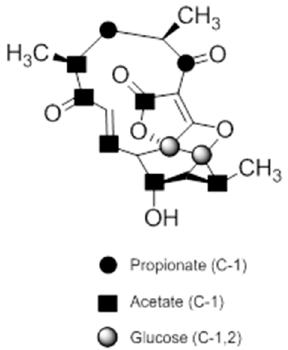
Figure 9. Incorporation of 13 C-labelled precursors into the polyketide backbone of abyssomicin C (modified from [73]).